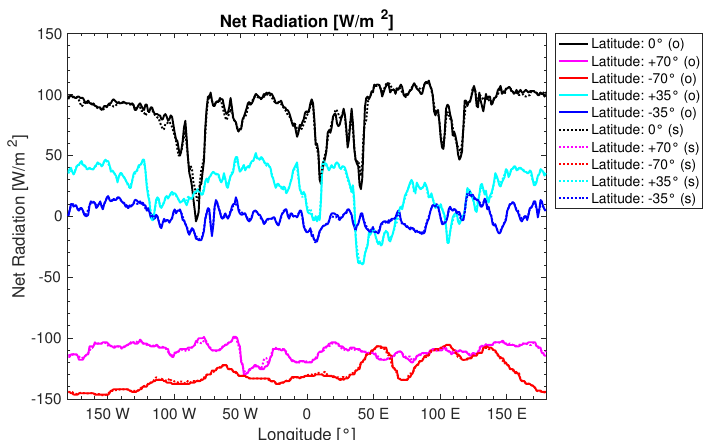
Figure 7. Daily Earth net radiation as a function of longitude for different terrestrial latitudes. (o) represents the real observations (CERES data). (s) represents the results obtained with a simulation of observations from a virtual constellation of 15 satellites (five different inclinations and three different LTAN).